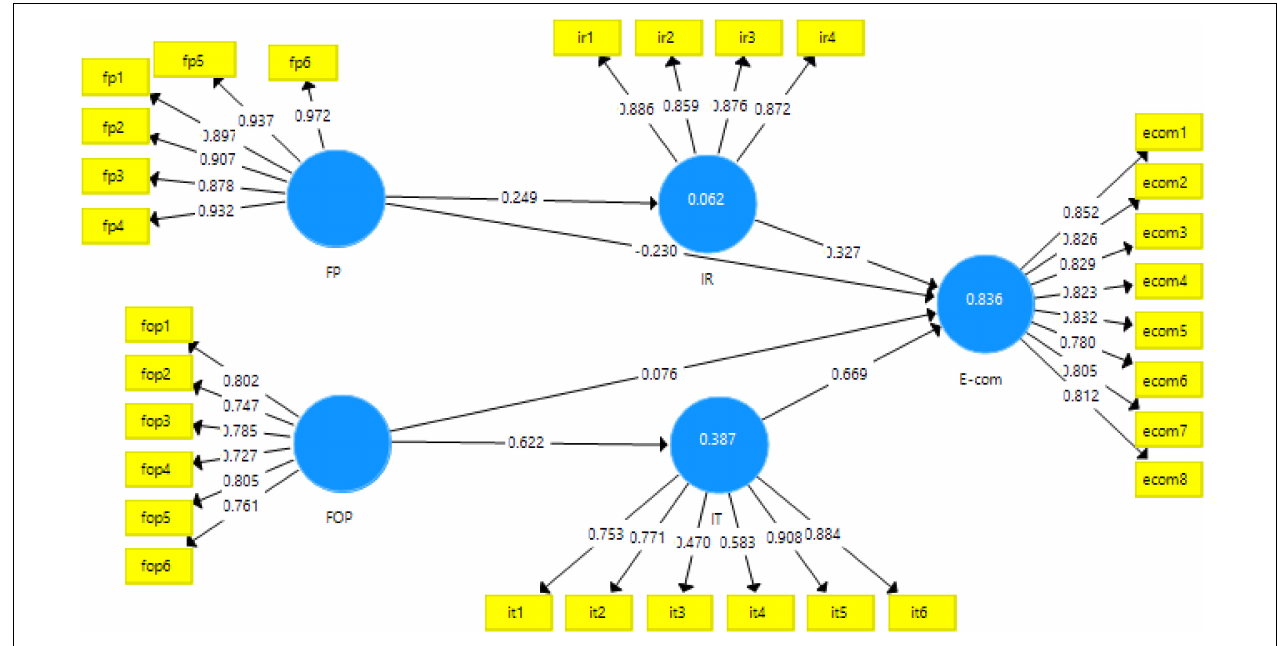
FIGURE 2 | PLS-algorithm for the measurement model.